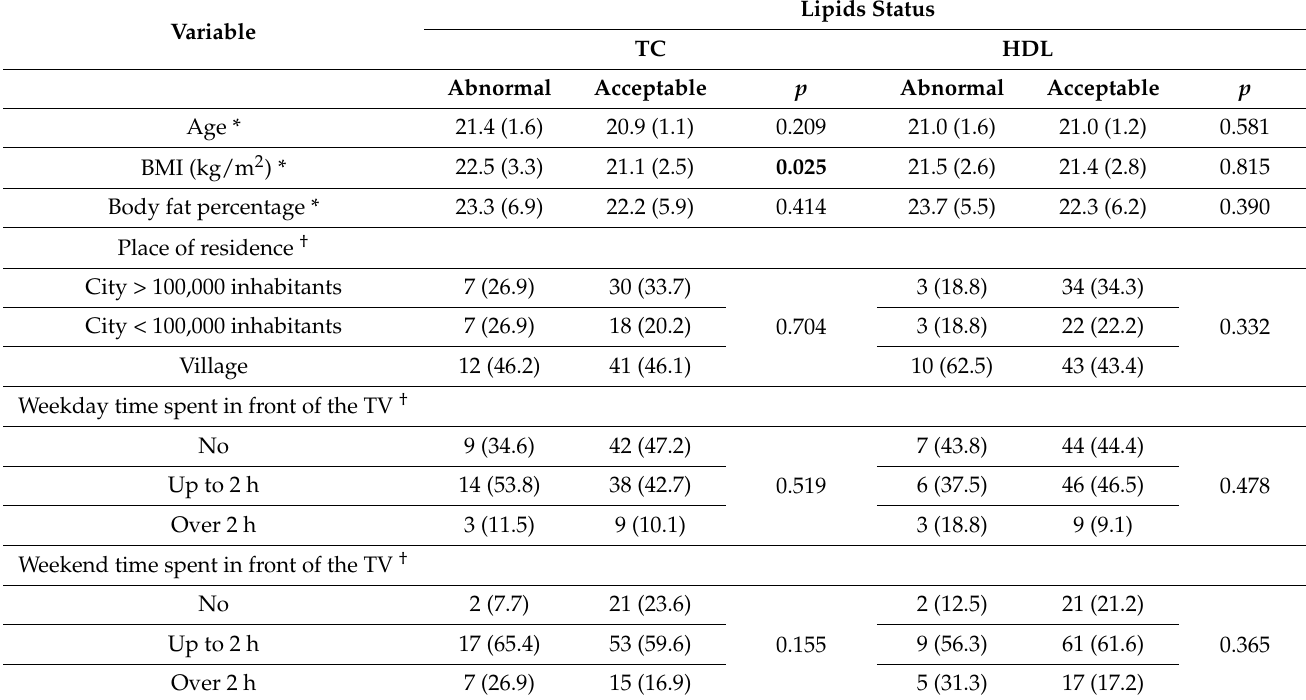
Table 5. Variables that influence the prevalence of abnormalities of TC and